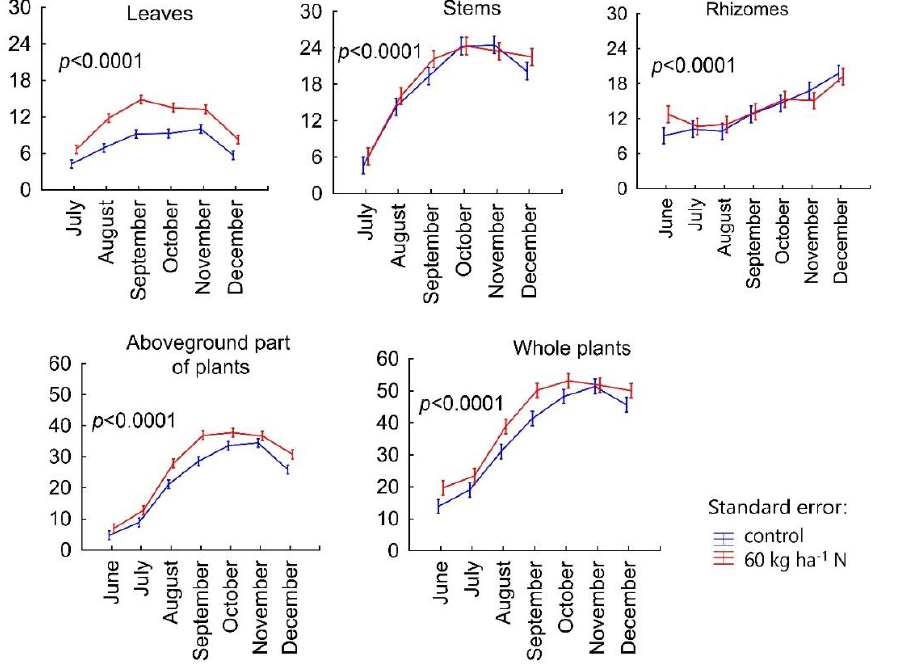
Figure 5. Potassium uptake in examined part of miscanthus (g m − 2 ) (three-year average content from measurements during the growing season every 30 days).